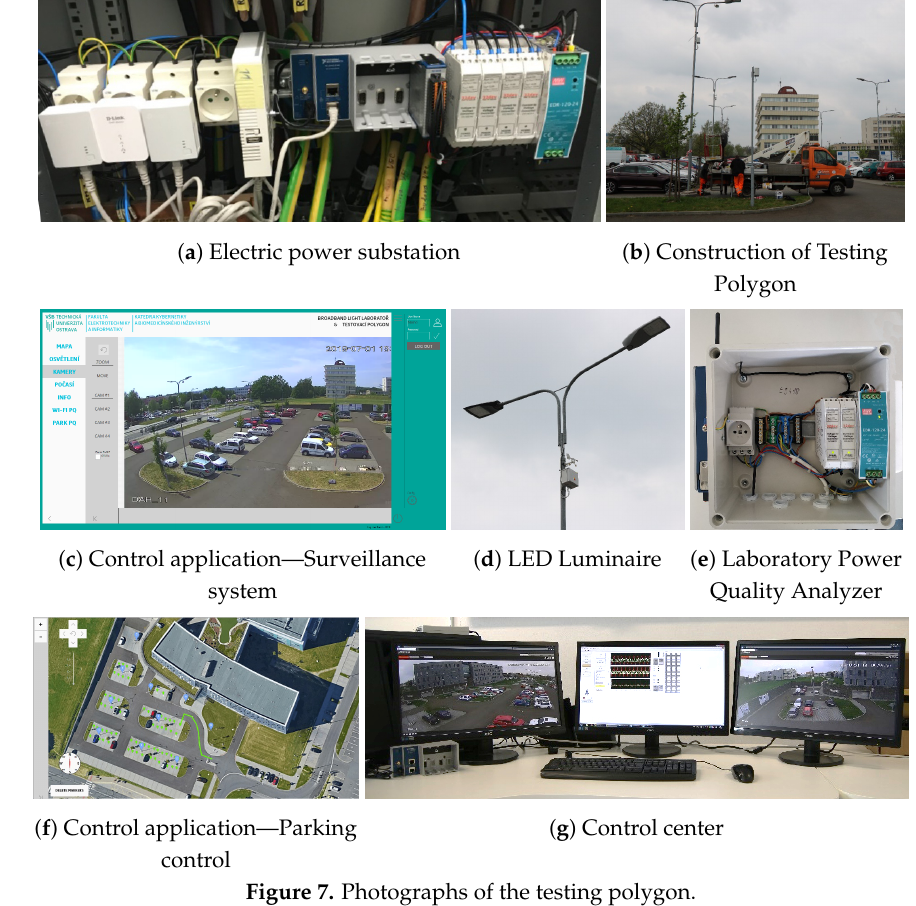
Figure 7. Photographs of the testing